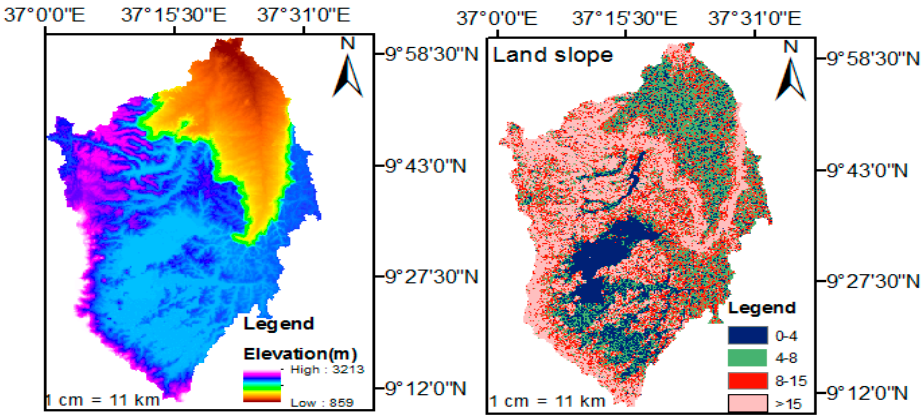
Figure 2. Elevation and slope maps of Finchaa catchment.